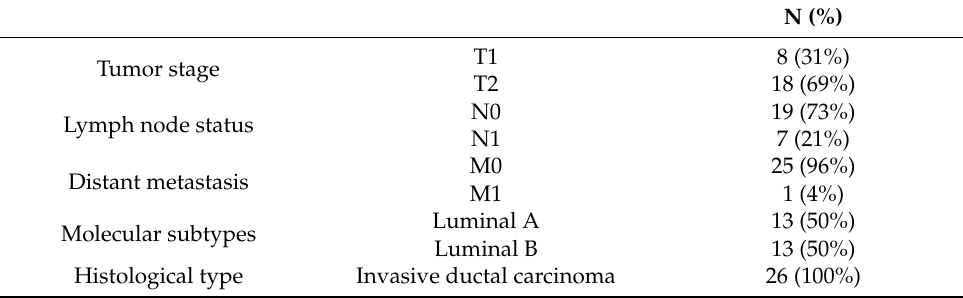
Table 3. Clinical characteristics of untreated